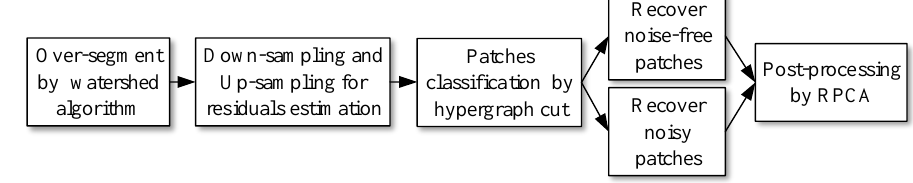
Figure 2. The framework of the proposed denoising algorithm for ICCD images.